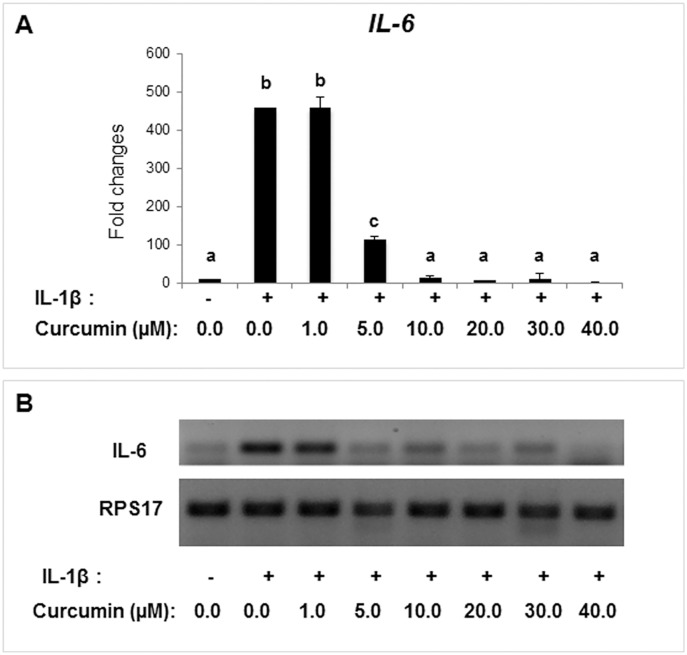
Dose dependent inhibition of IL-1β-stimulated IL-6 expression by curcumin.HuF cells were treated with vehicle (control), IL-1β (10ng/ml), or with combinations of IL-1β (10ng/ml) and different doses of curcumin (0–40μM) for 24 hr. Total mRNA was analyzed for IL-6 expression by qPCR and RT- PCR. RPS17 expression was used as control. The values are expressed as the means ± S.E. (n = 3). ab, p < 0.001; bc, p < 0.001; ac, p < 0.01.